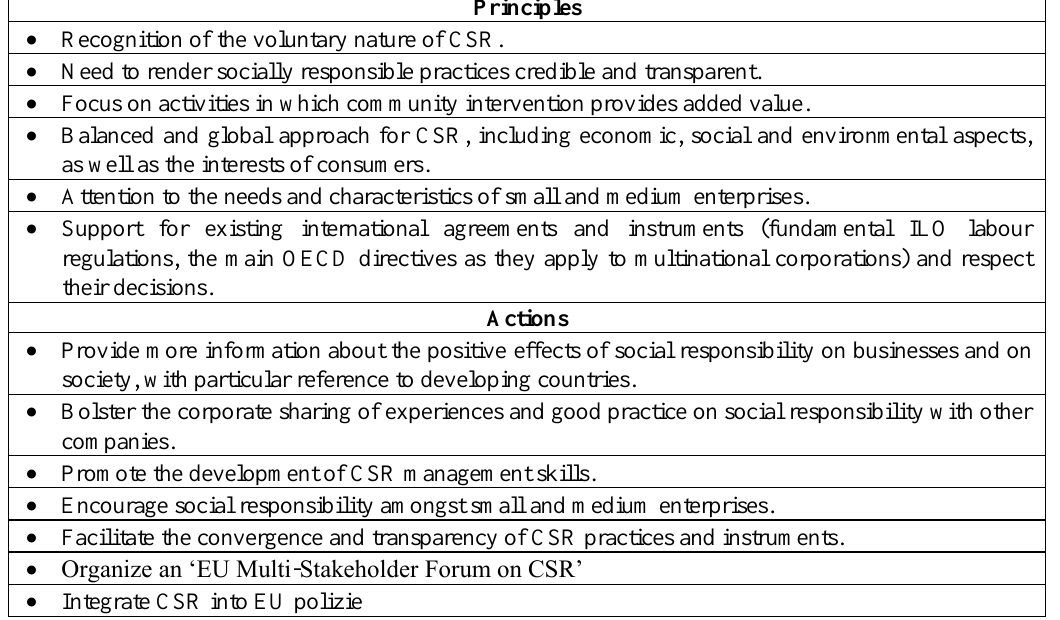
Figure 5: Strategies for the Promotion of Corporate Social Responsibility